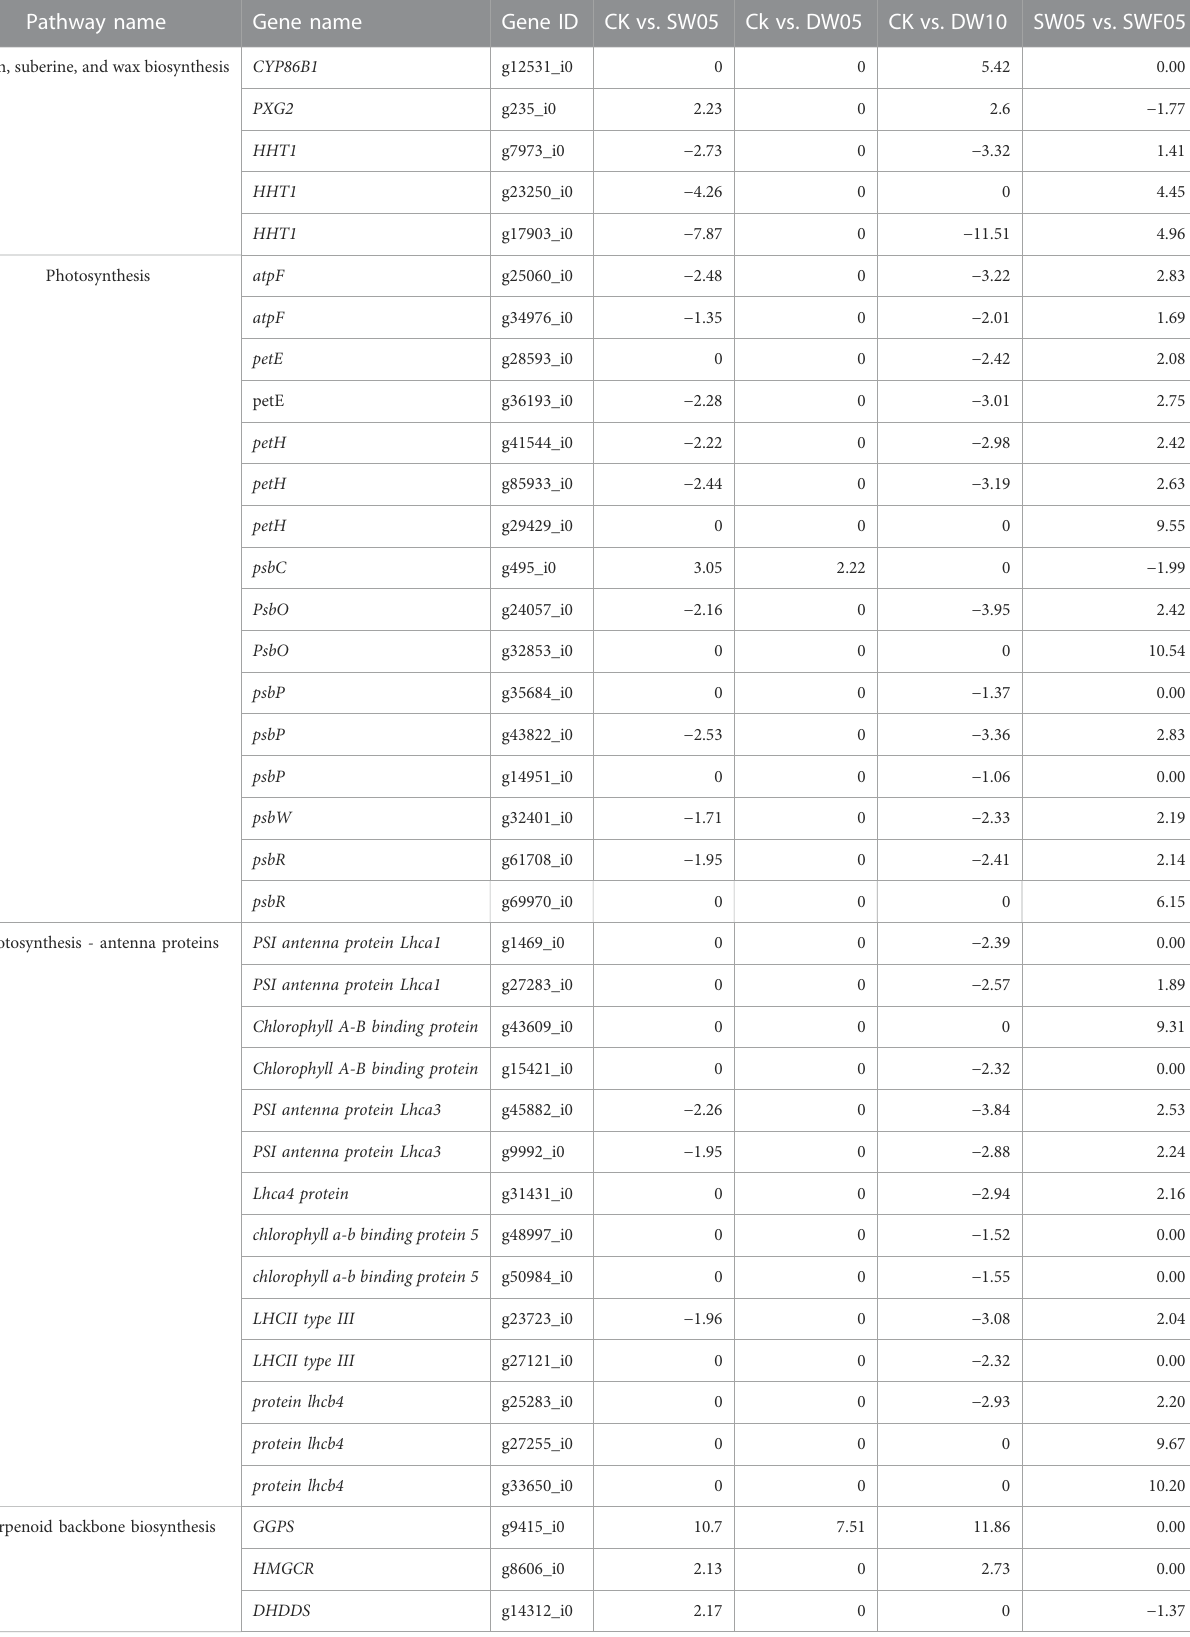
TABLE 1 Details of important differentially expressed genes from different pathways in response to half-waterlogging, drought, and